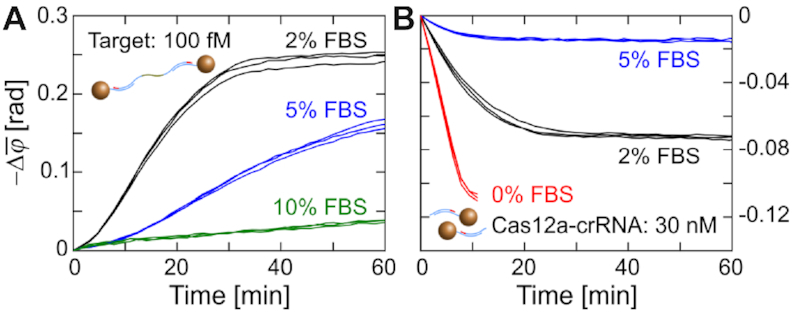
Performance of PG-RCA and CIRI in diluted FBS samples. Real-time changes of \documentclass[12pt]{minimal}
\usepackage{amsmath}
\usepackage{wasysym}
\usepackage{amsfonts}
\usepackage{amssymb}
\usepackage{amsbsy}
\usepackage{upgreek}
\usepackage{mathrsfs}
\setlength{\oddsidemargin}{-69pt}
\begin{document}
}{}$\bar{\varphi }$\end{document} (1–10 Hz) are recorded for (A) PG-RCA of 100 fM target DNA and (B) cleavage of MNP clusters by preformed Cas12a ternary complexes. Final concentrations of FBS are indicated in panels. Independent replicates (n = 3) are plotted in the same color. Red curves in panel (B) are from Figure 2B for reference.